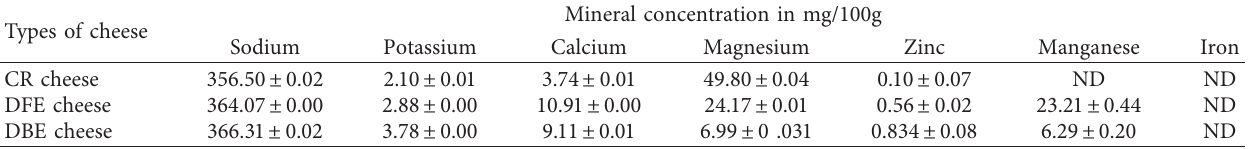
Table 10: Mineral concentrations of ripened cheese (after 2 months of ripening). Types of